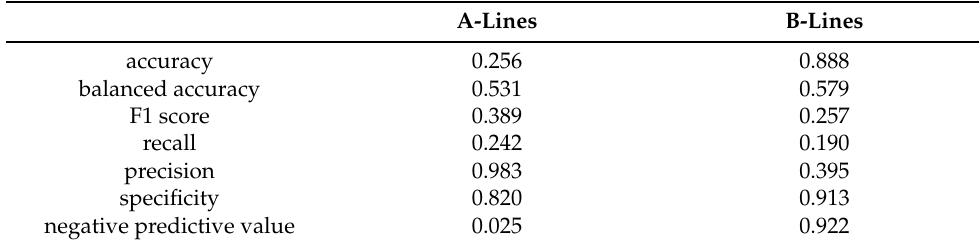
Table 6. Segmentation accuracy over real-life data.